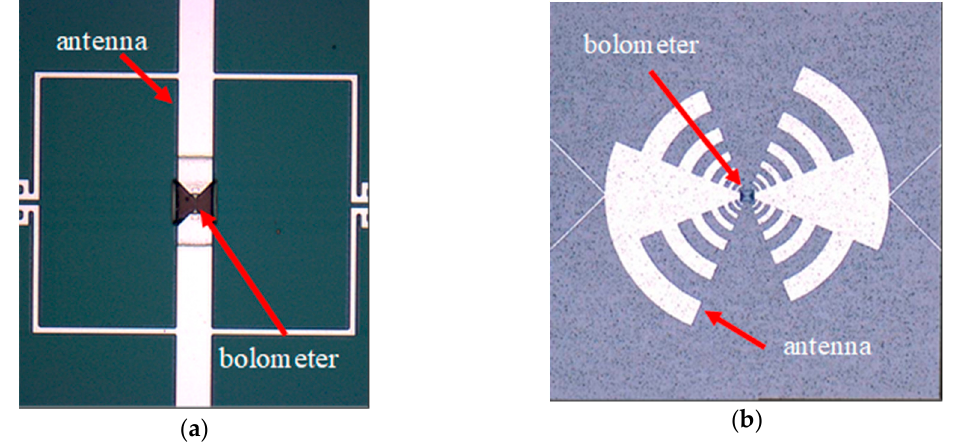
Figure 1. THz sensors for different THz bands: ( a ) A 300 GHz narrow-band antenna with Ti micro-bolometer; ( b ) Wide-band antenna with Ti micro-bolometer (the receiving region is from 80 GHz to 1.1 THz).